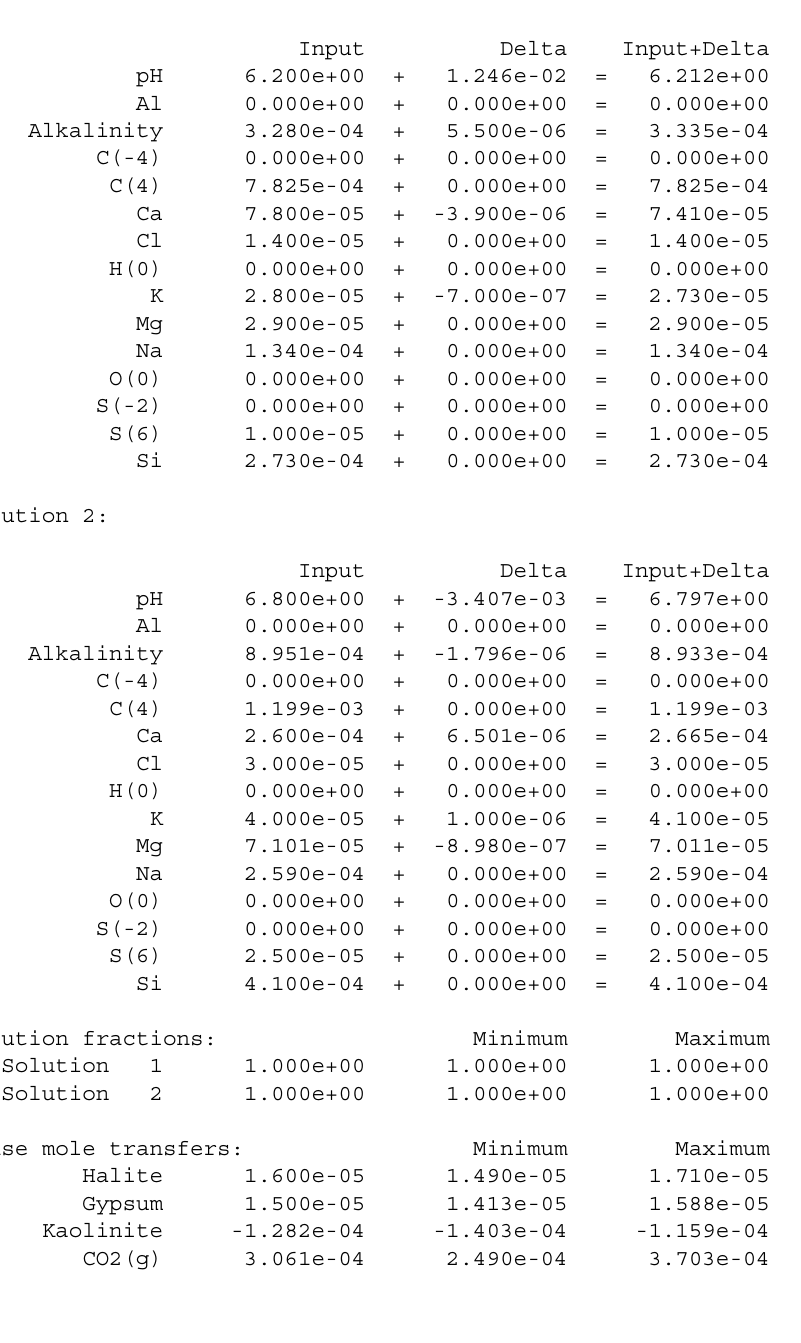
Table 48. Selected output for example 16.—Continued Redox mole transfers: Sum of residuals (epsilons in documentation): Sum of delta/uncertainty limit: Maximum fractional error in element concentration: Model contains minimum number of